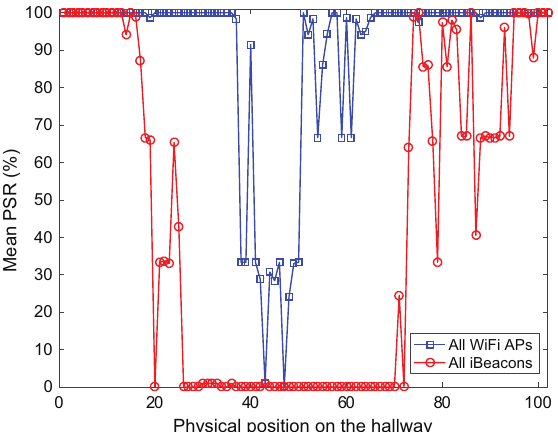
Figure 5. Mean packet success rate (PSR) computed using pedestrians’ smartphones in test positions (orange circles in Figure 4) of test case